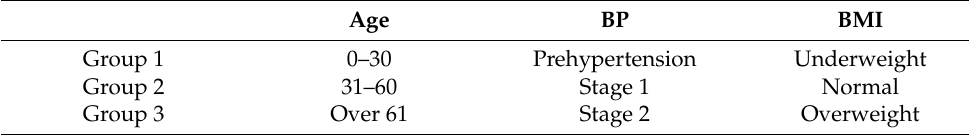
Table 1. Group division for continuous